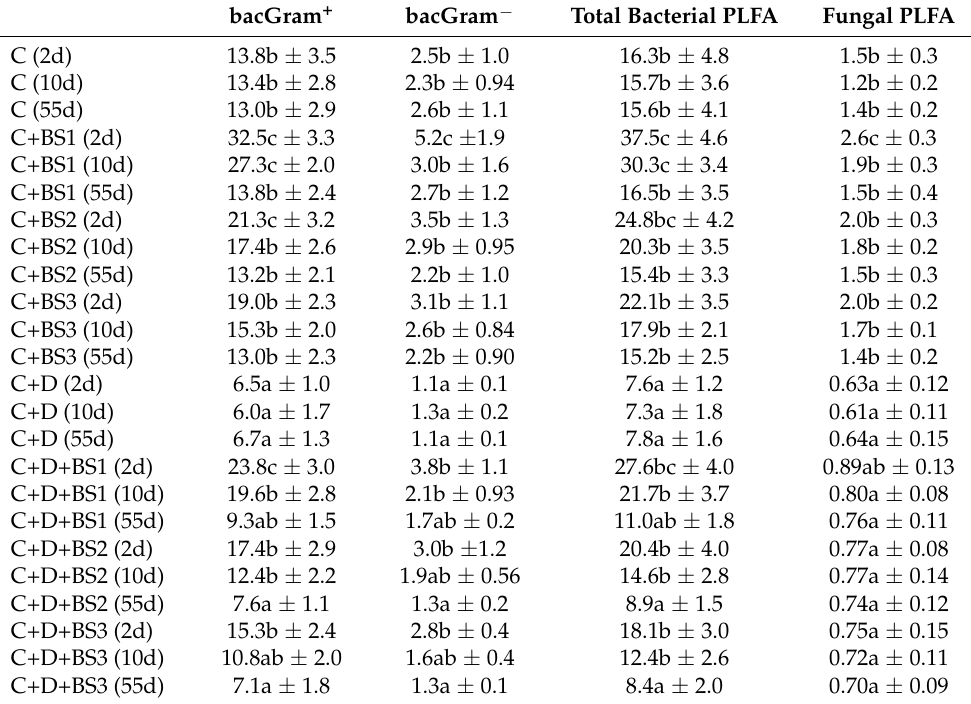
Table 5. Evolution of bacterial Gram + , bacterial Gram - , total bacterial and fungal PLFAs (nmol g − 1 ) during the experimental period. Data are the means of three samples. Columns (mean ± S.E.) followed by the same letter(s) are not significantly different ( p >